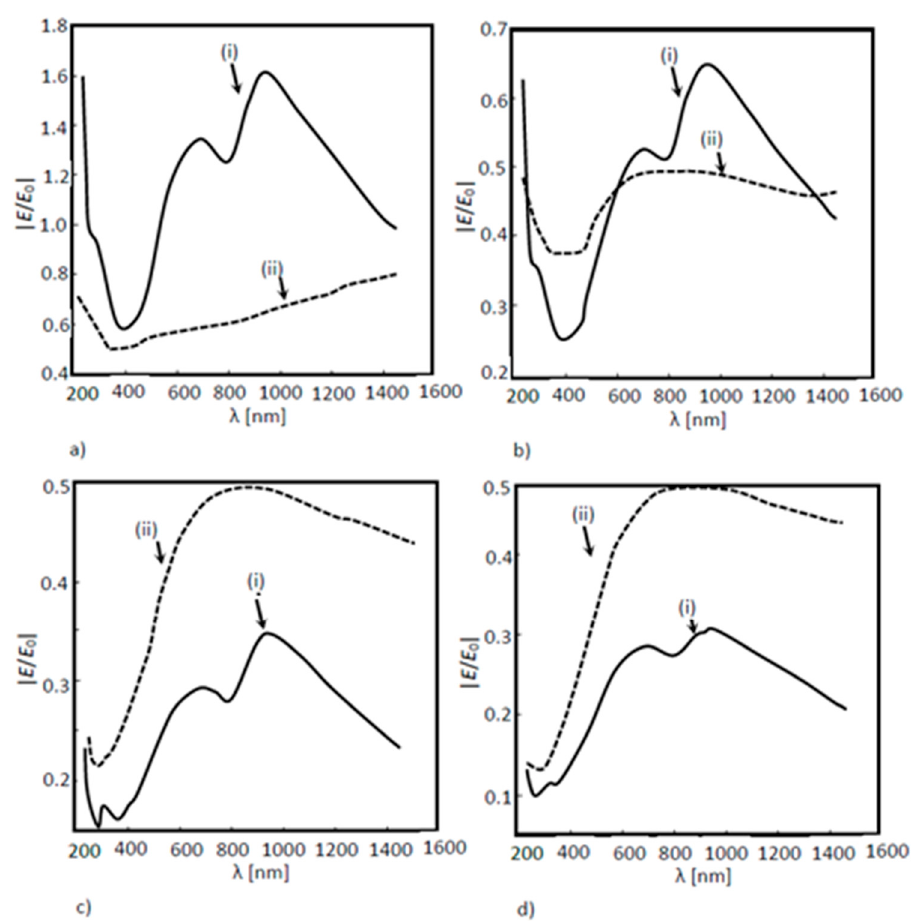
Figure 7. Normalized electric field as a function of the wavelength for a 3D a-Si solar cell structure. Measures were performed in four different positions: ( a ) P 1 , ( b ) P 2 , ( c ) P 3 and ( d ) P 4 for two different situations: (i) without a nanoantenna and (ii) with a nanoantenna.